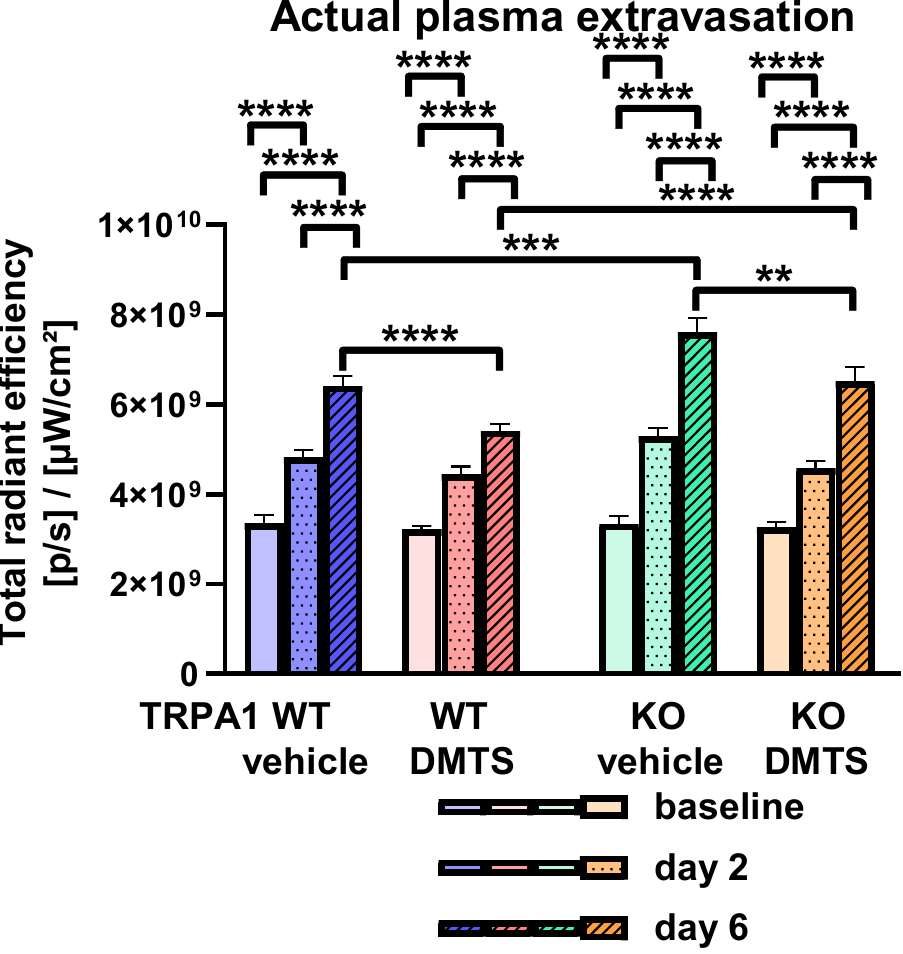
Figure 4. DMTS treatment lowered plasma extravasation rate 6 days after the injection of arthritogenic serum in TRPA1 WT and KO mice. The rate of plasma extravasation was detected by fluorescent imaging of IR676. Solid bars represent baseline values, dotted bars show fluorescence at day 2, and striped bars indicate plasma extravasation at day 6. One-way ANOVA and Holm-Sidak’s test: n = 16–20. ** p < 0.01, *** p < 0.001, **** p < 0.0001 vs. indicated group.